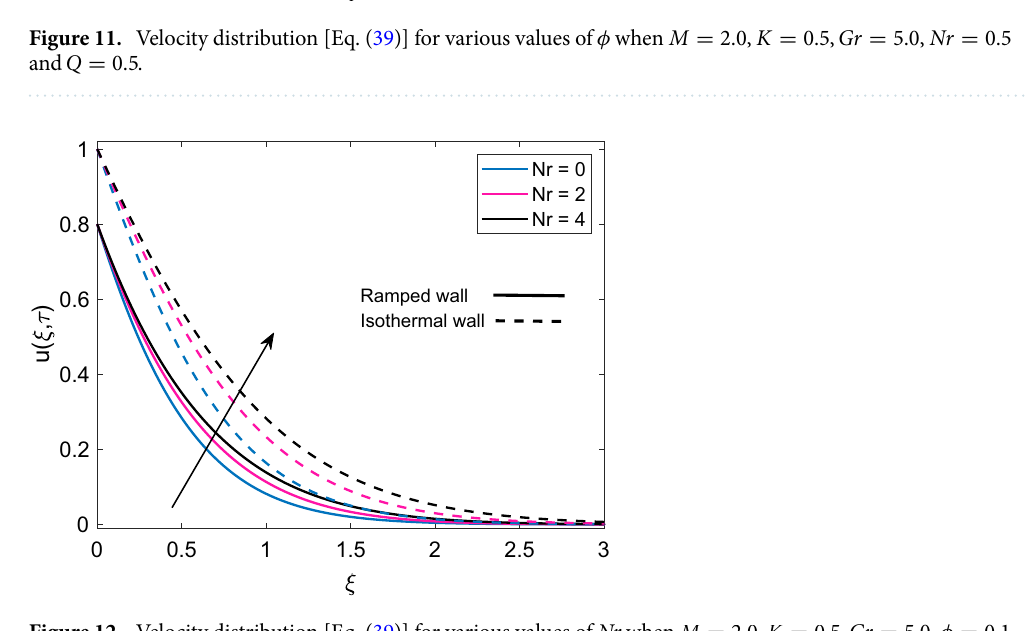
Figure 12. Velocity distribution [Eq. (39)] for various values of Nr when M = 2.0 , K = 0.5 , Gr = 5.0 , φ = 0.1 and Q = 0.5